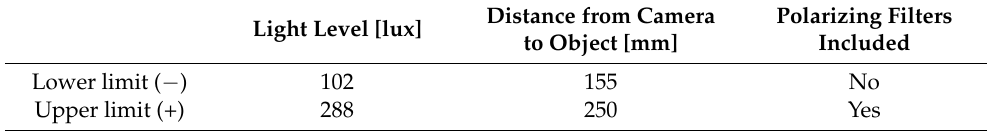
Table 3. Camera and setup